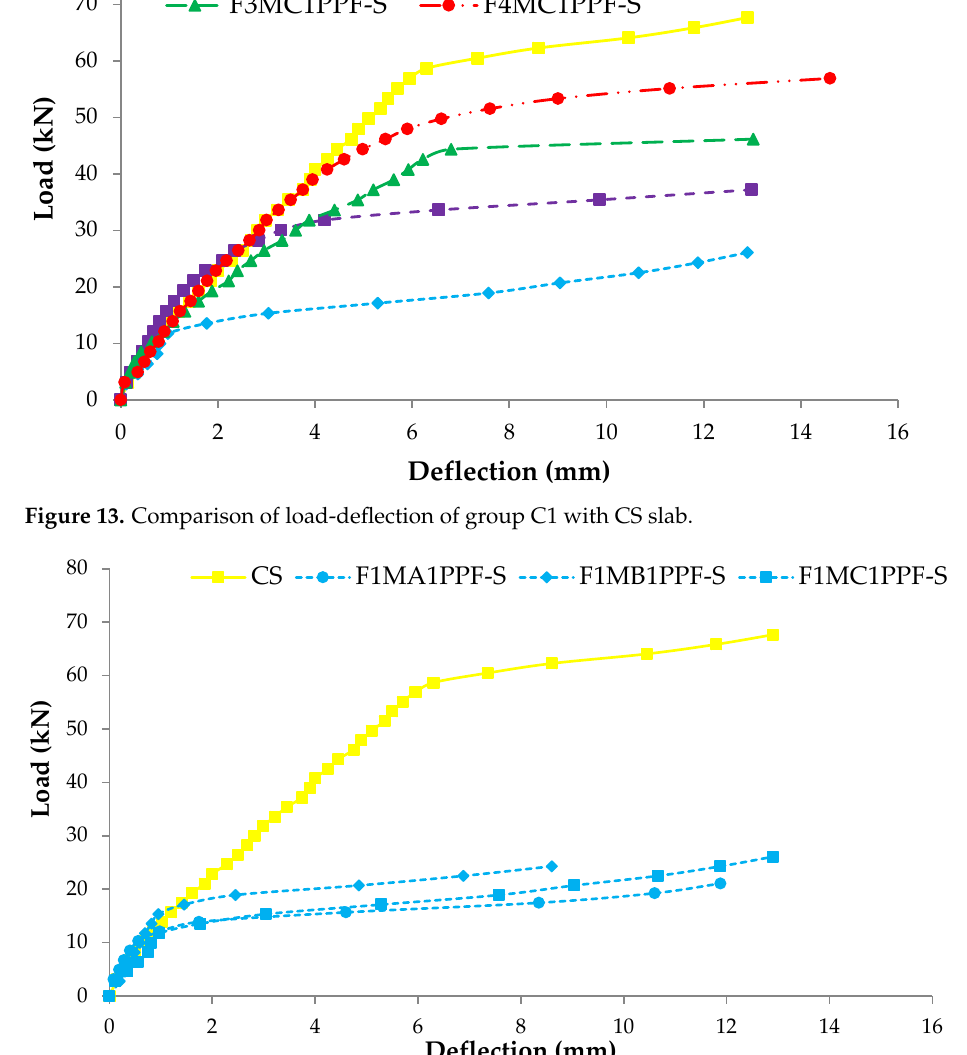
Figure 14. Comparison of load-deflection for different % of PPF and one steel wire mesh.